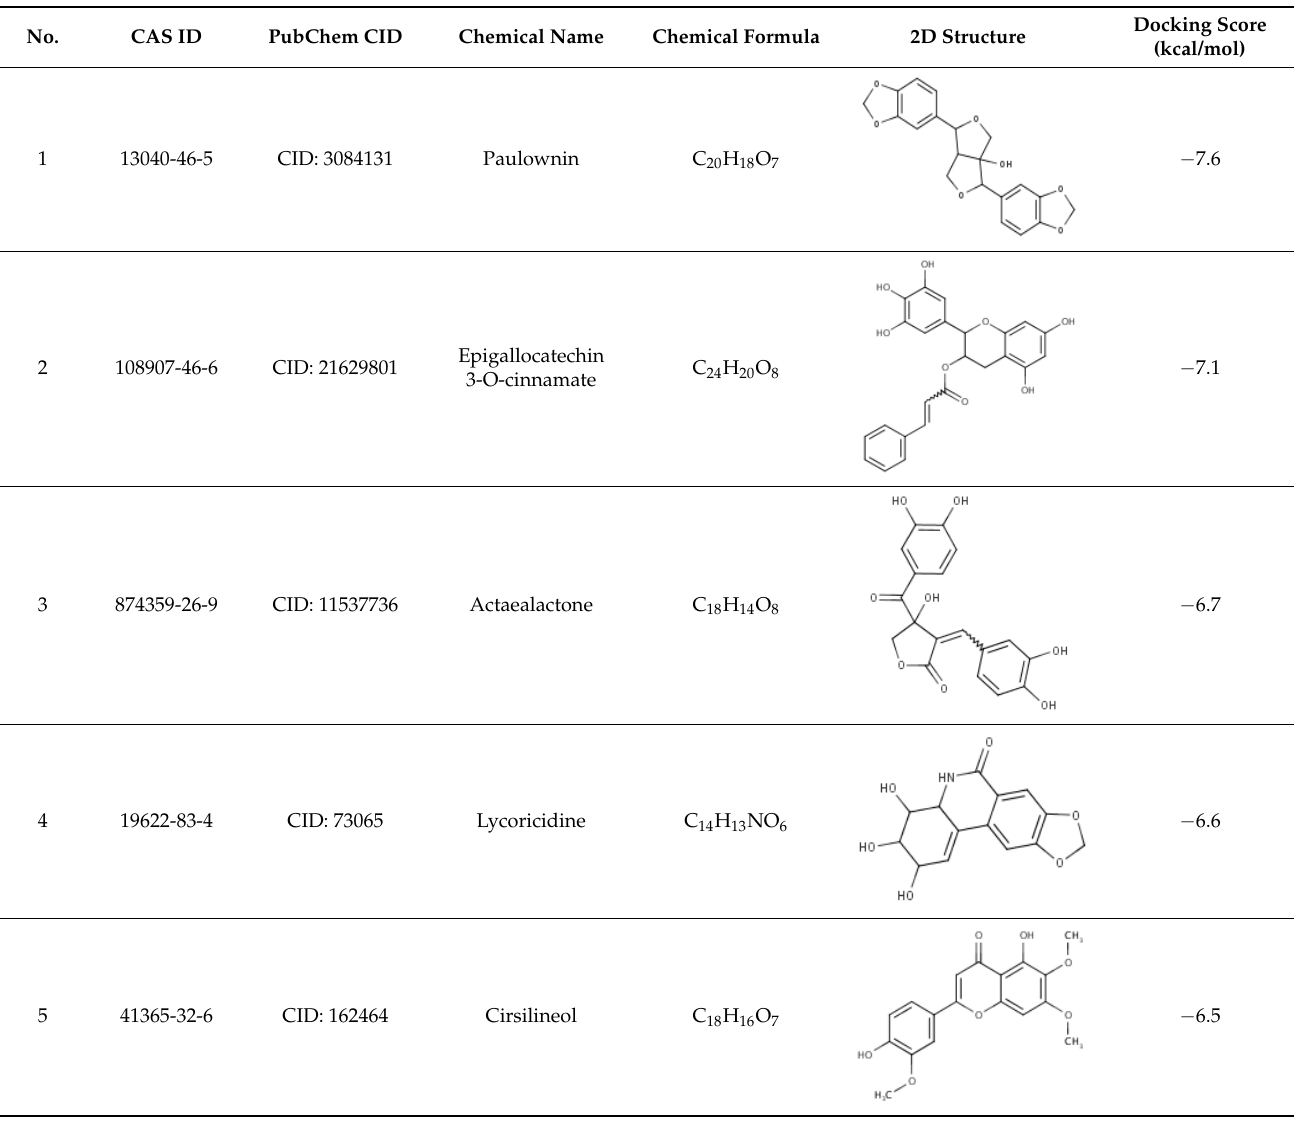
Table 1. List of compounds, CAS ID, PubChem CID, chemical formula, and two-dimensional (2D) structure of the five selected compounds with the highest binding affinity.